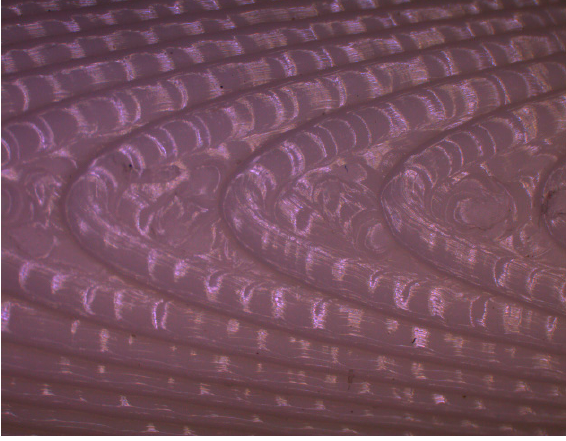
Figure 9. Plan view of a sample with print orientation angle of 85° .